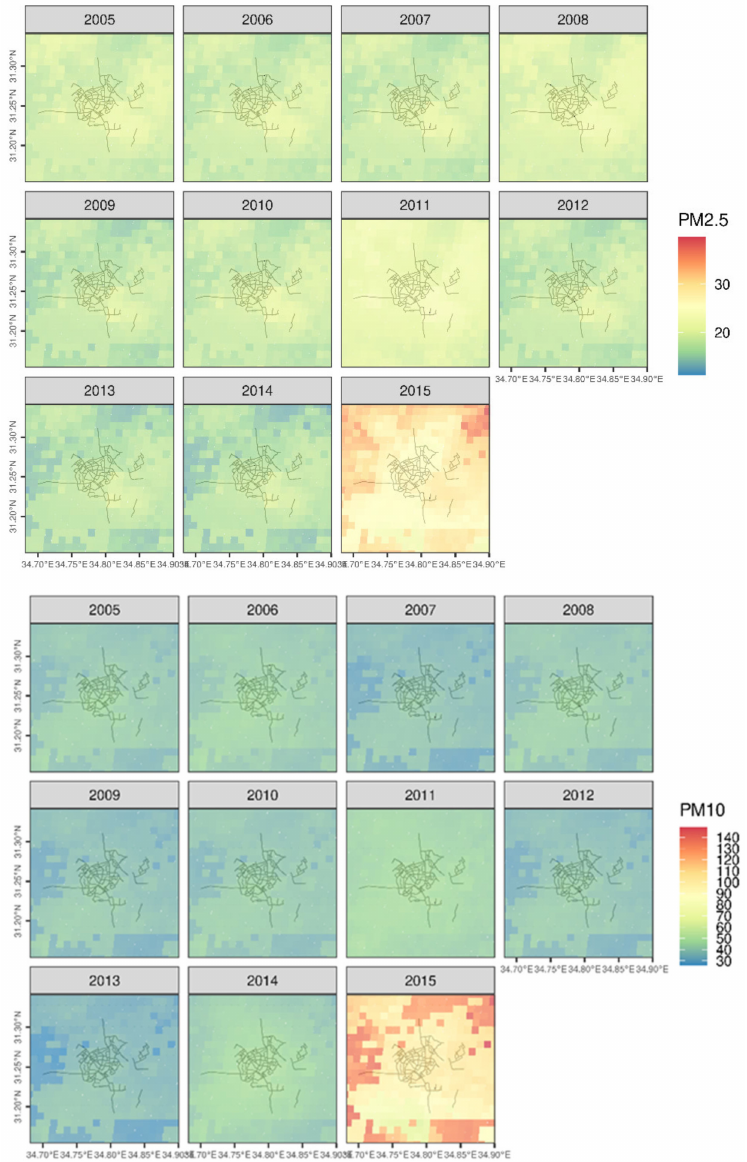
Figure 8. Average particulate matter (PM) per 1 km 2 pixel in September of 2005–2015 in the city of Beer Sheva based on satellite model predictions (Top: PM2.5, bottom: